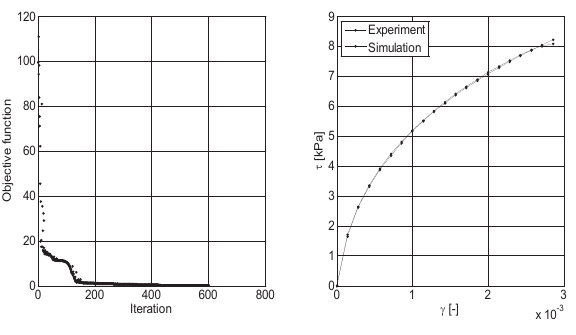
Figure 11: Exemplary discretisation of sample S3057. Fig. 11. Exemplary discretisation of sample S3057. Fig. 11. Exemplary discretisation of sample S3057.